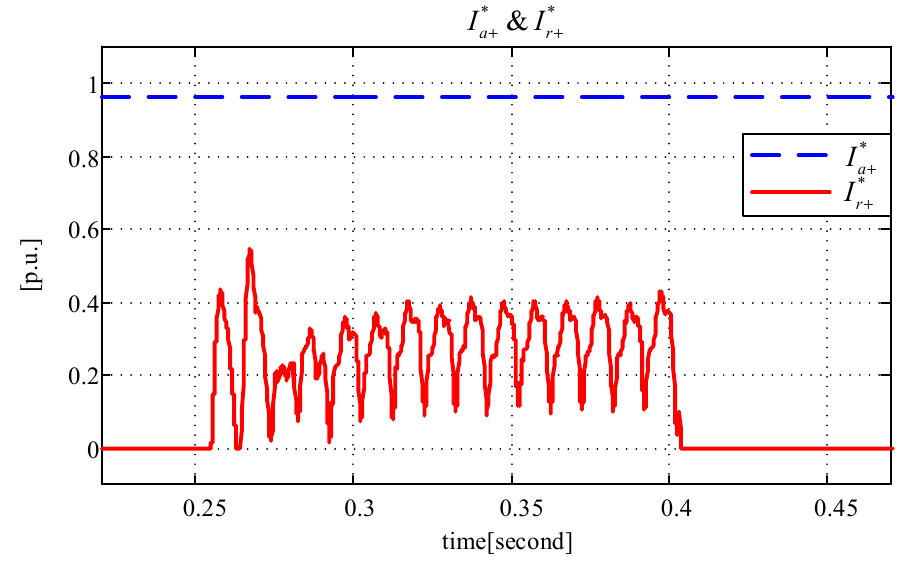
Figure 20. Set points of active and reactive currents in positive sequence in case of 1ph 100% voltage sag without injecting negative sequence current.